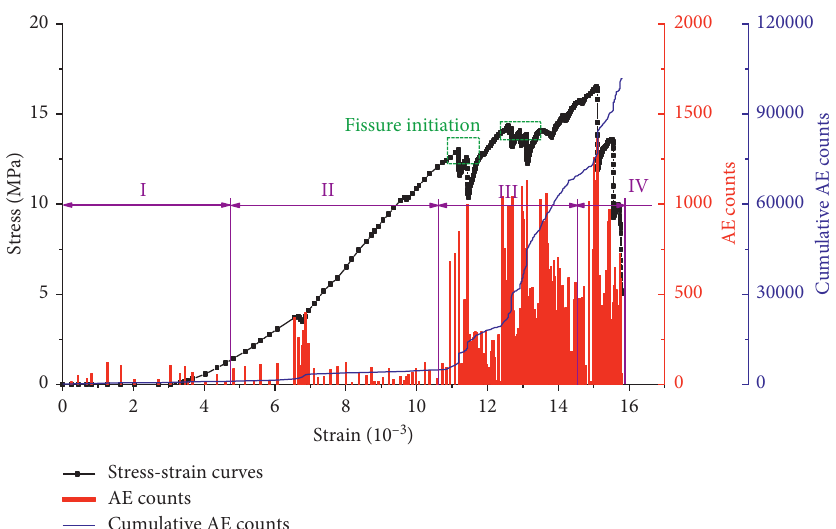
Figure 7: Stress-strain curve and acoustic emission monitoring curve of coal sample after immersion in alkaline solution.